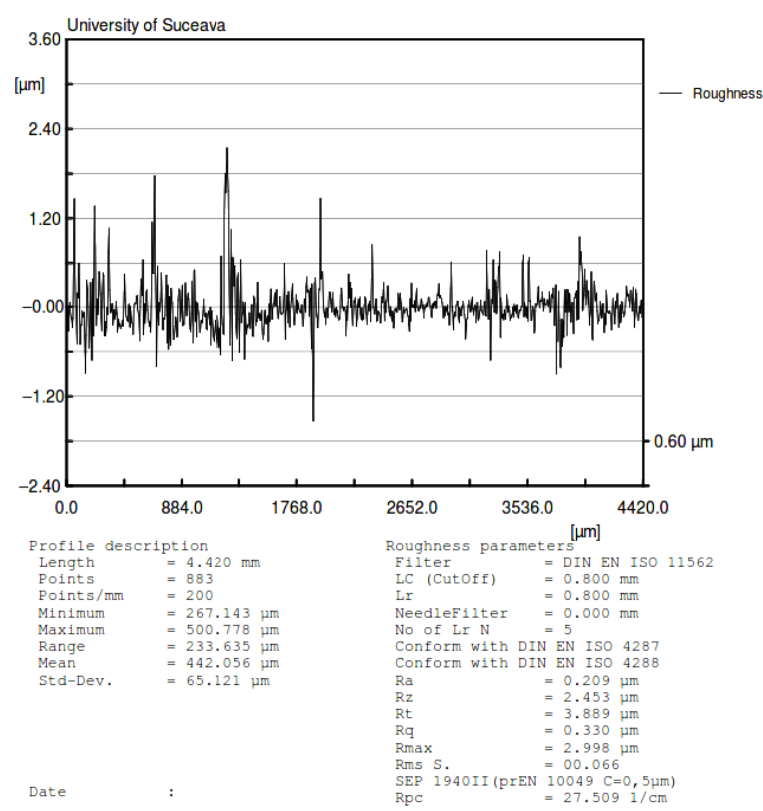
scanning resolution) and the results are also presented in Table 2. Figure 14. Profile of the aluminum plate with values of roughness. Figure 14. Profile of the aluminum plate with values of roughness.